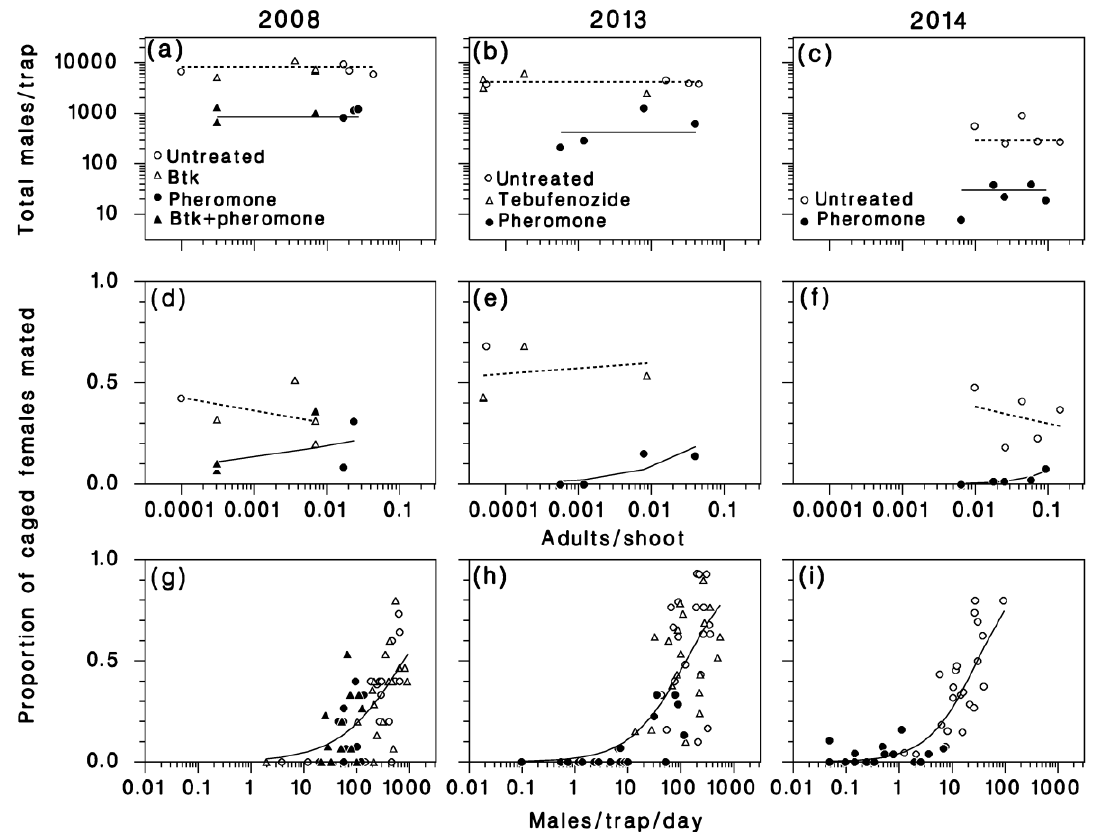
Figure 4. First row ( a , b , c ): Total capture of males per pheromone trap vs. adults per shoot, (lines: Equation 1, ─── : With pheromone; ∙∙∙∙∙∙ : Without). Second row ( d , e , f ): Mating success vs. adults per shoot, (lines: Equation 2). Third row ( g , h , i ): Relationship between mating success of caged virgin females and the daily capture rate of males in pheromone traps during the exposure period (lines: Logistic regression). Left column: 2008. Center column: 2013. Right column: 2014.